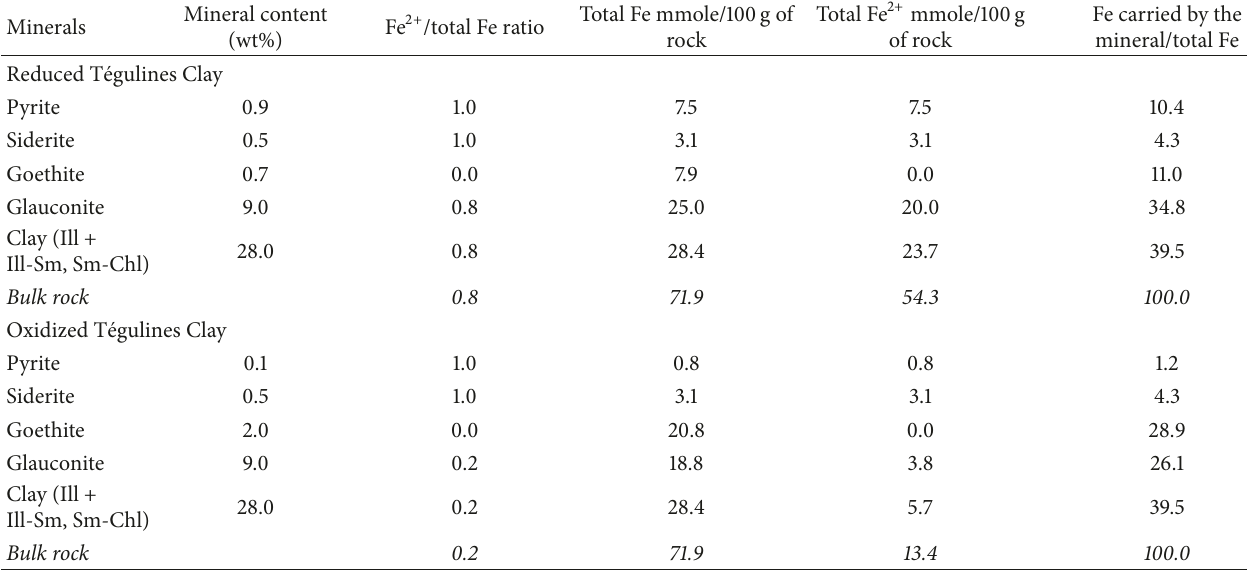
Table 3: Distribution and iron speciation in iron-bearing minerals of well-preserved reduced T´egulines Clay and weathered T´egulines Clay. Fe carried by the Mineral content Total Fe mmole/100 g of Total Fe 2+ mmole/100 g Minerals Fe 2+ /total Fe ratio of rock mineral/total Fe (wt%) rock Reduced T´egulines